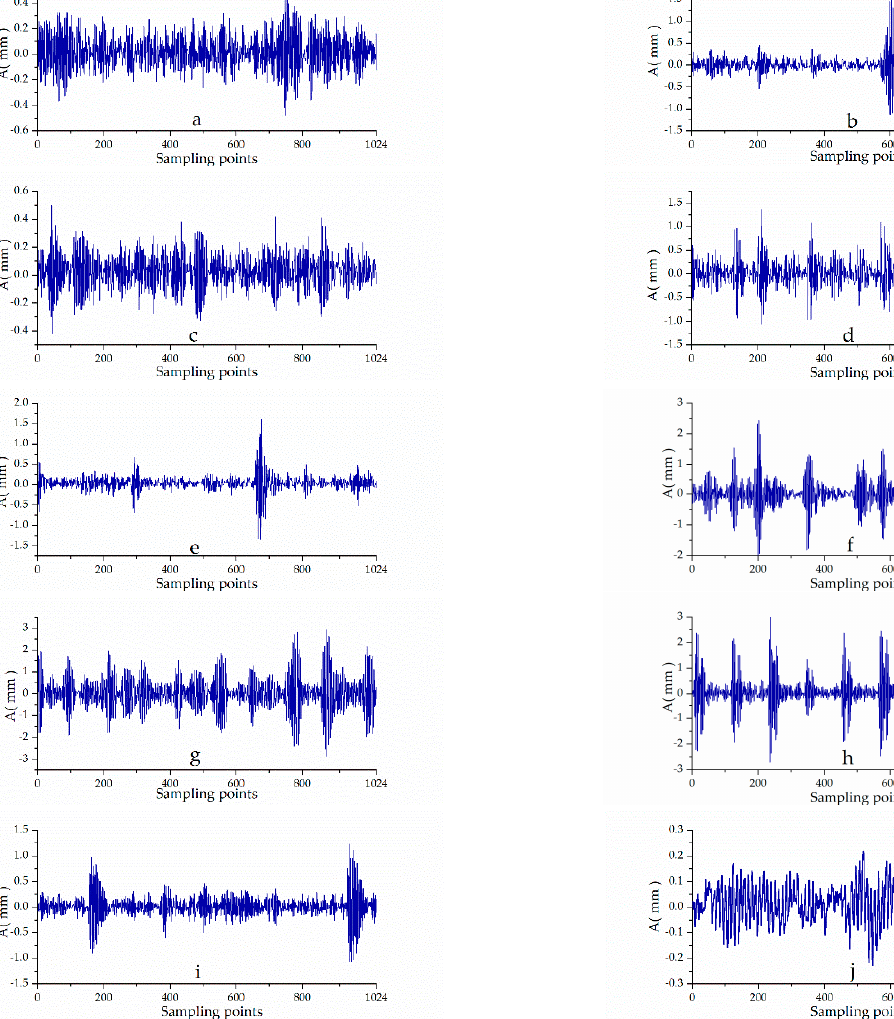
Figure 6. Sample raw vibration signals from CWRU 0 HP dataset (as referred in Table 1). The y -axis represents the amplitude of signal and x -axis is the number of sampling points.